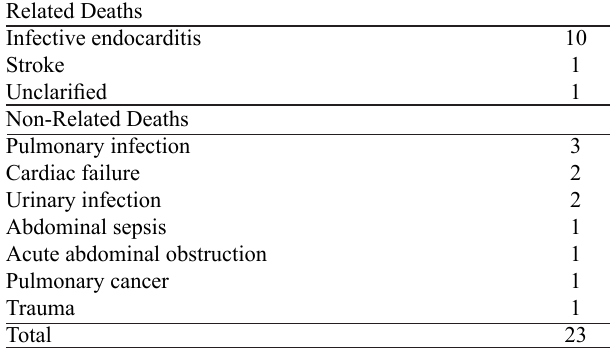
Table 2. Late mortality